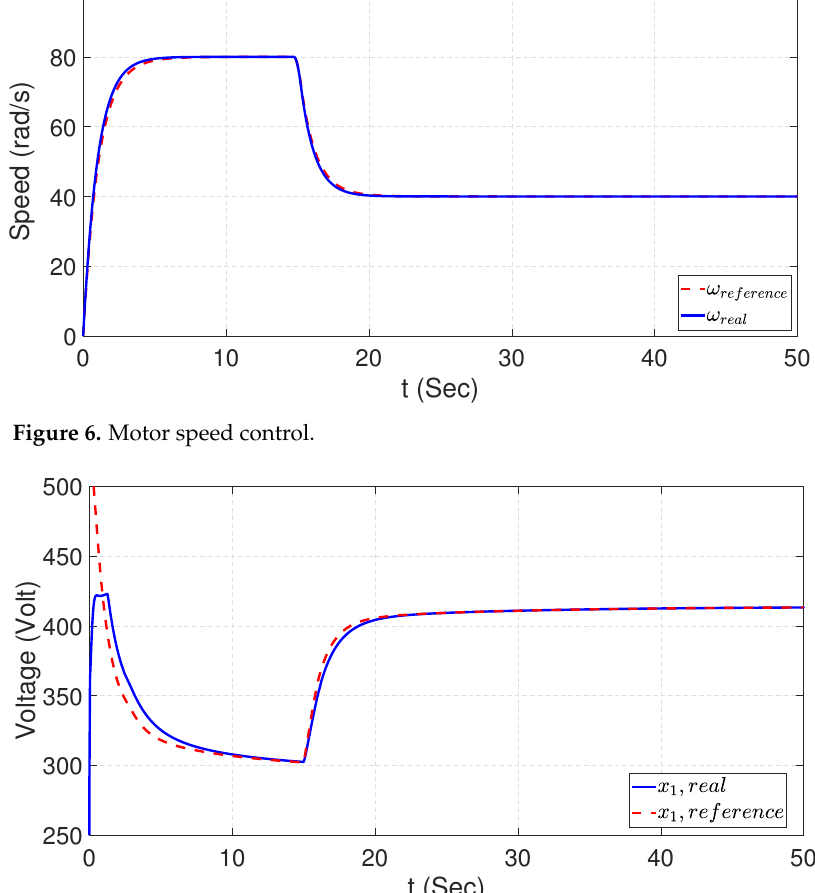
Figure 7. AES voltage control during regenerative braking.